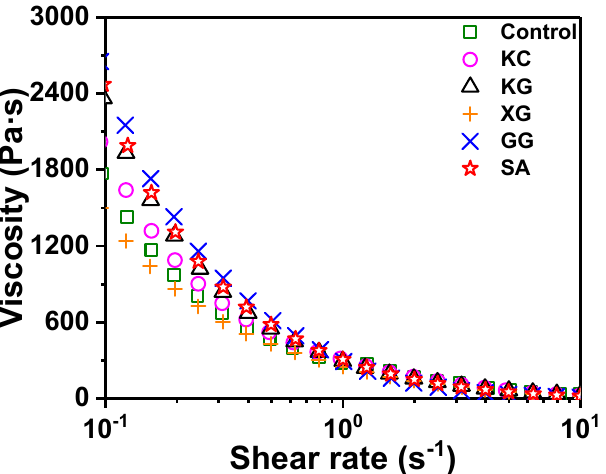
Figure 2. Effects of different polysaccharides on apparent viscosity of unwashed surimi gel. KC: κ -carrageenan; KG: konjac gum; XG: xanthan gum; GG: guar gum; SA: sodium alginate.